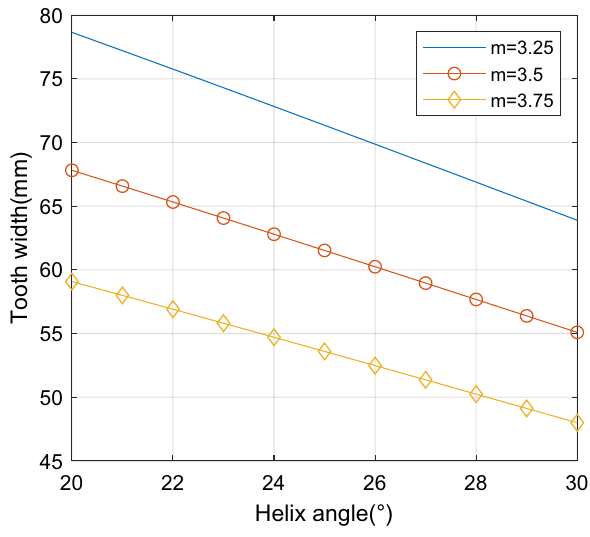
Fig. 17 Tooth width value of different modulus and helix angle at equal bending strength of the teeth and pressure angle of 22.5°